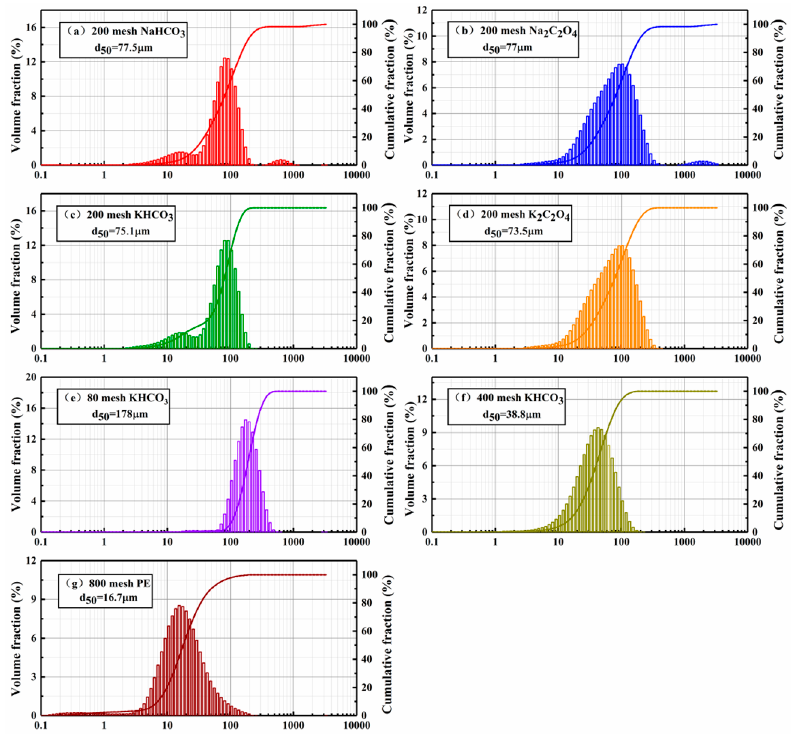
Figure 3. Particle size distributions of different dust particles.